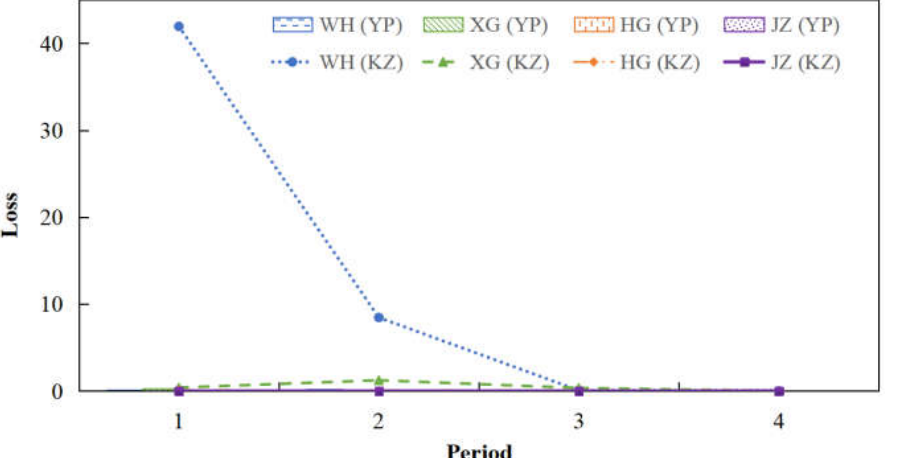
Figure 10. Losses due to shortages of emergency materials at each affected site in each time period based on the balance-criterion.